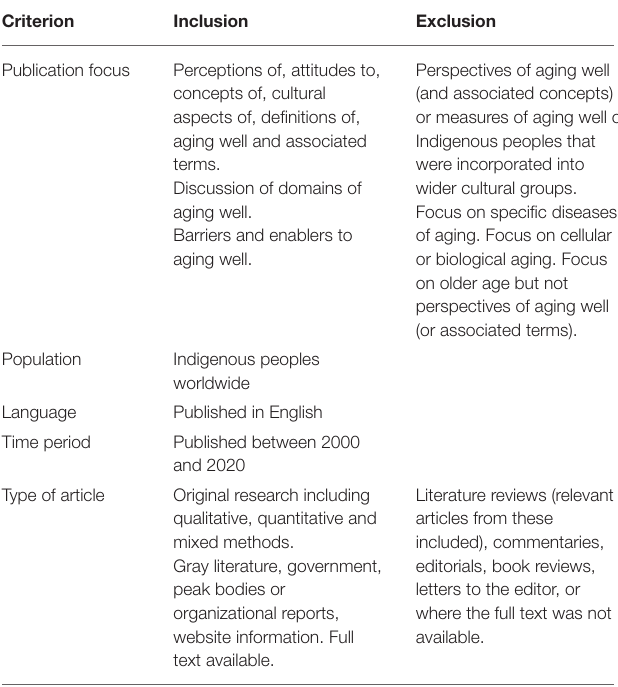
TABLE 1 | Inclusion/exclusion criteria for scoping review